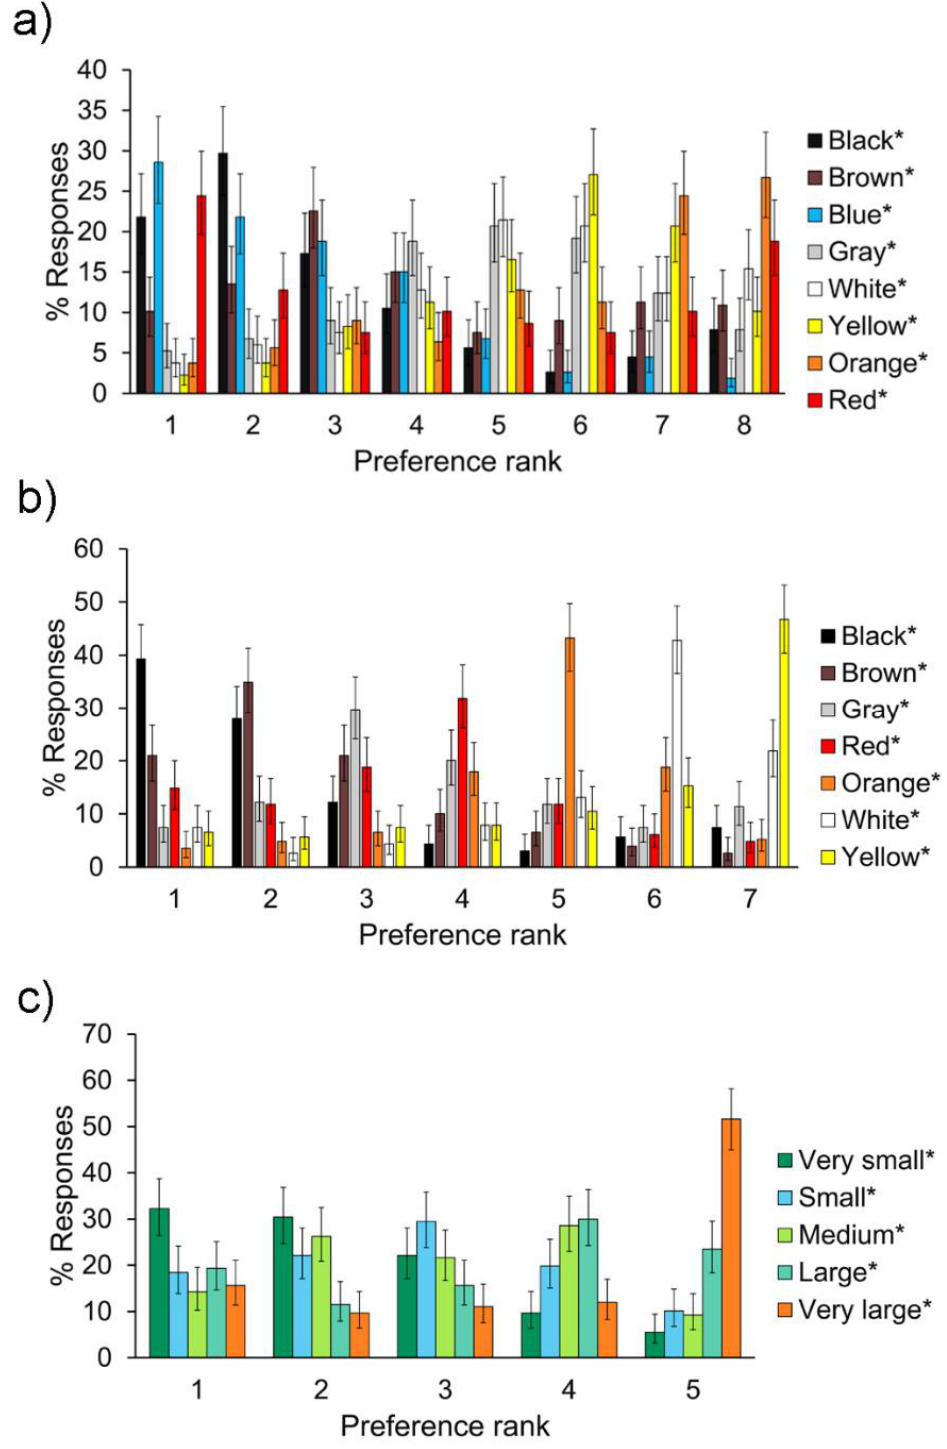
Figure 1. Human preferences (% responses ± 95% CI (Wilson score)) for the primary color ( a ), secondary color ( b ), and body size ( c ) of forest generalist and edge/open country songbird species. Preference rank varied from most (1) to least (5 or 7) preferred. Asterisks indicate that, for a given trait category, the distribution of the number of responses across ranks differed significantly ( p < 0.001) from the expectation that all ranks had an equal number of responses.